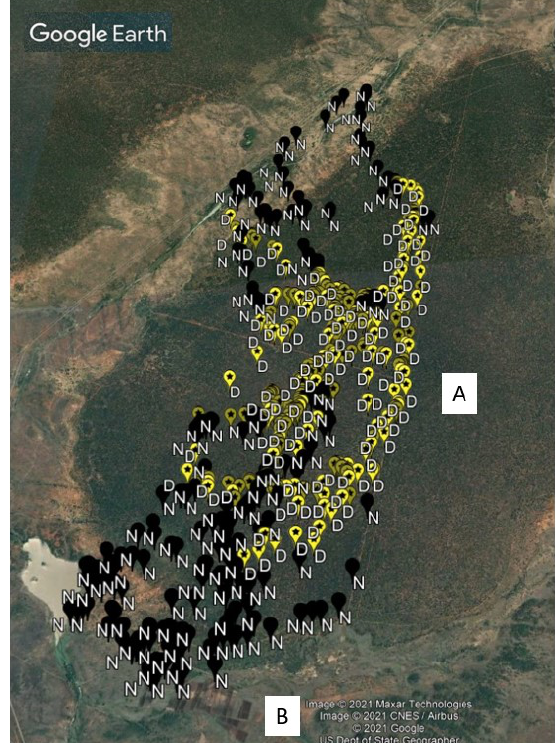
Figure 6 . Google Earth provides an accessible platform for displaying Bull 15 movements. Yellow “D” points mark day locations and black “N” points mark night locations. In the month of March, Bull 15 stayed within private lands during the day (A), while at night, Bull 15 broke fences and entered communal lands to raid crops